Question: What kind of plot is shown here?
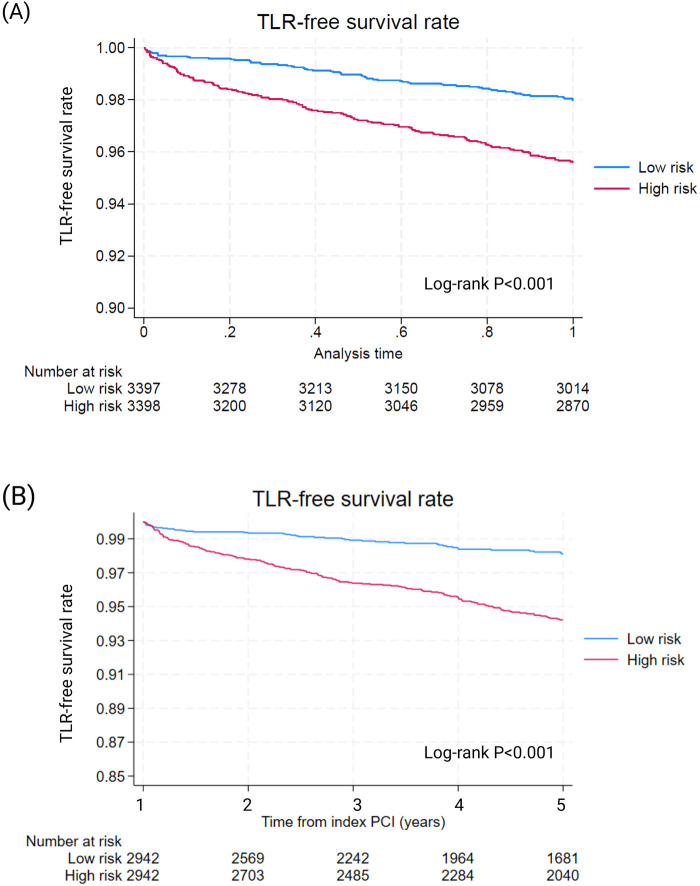
Answer: survival